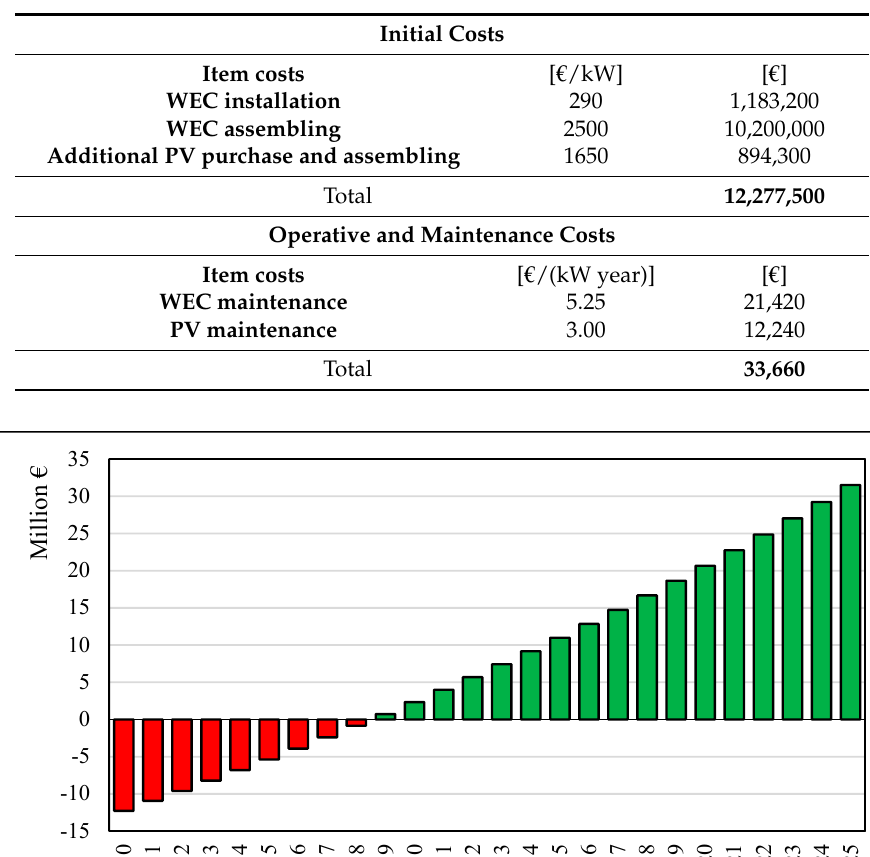
Table 4. Initial cost items, operative, and maintenance costs of the wave farm.